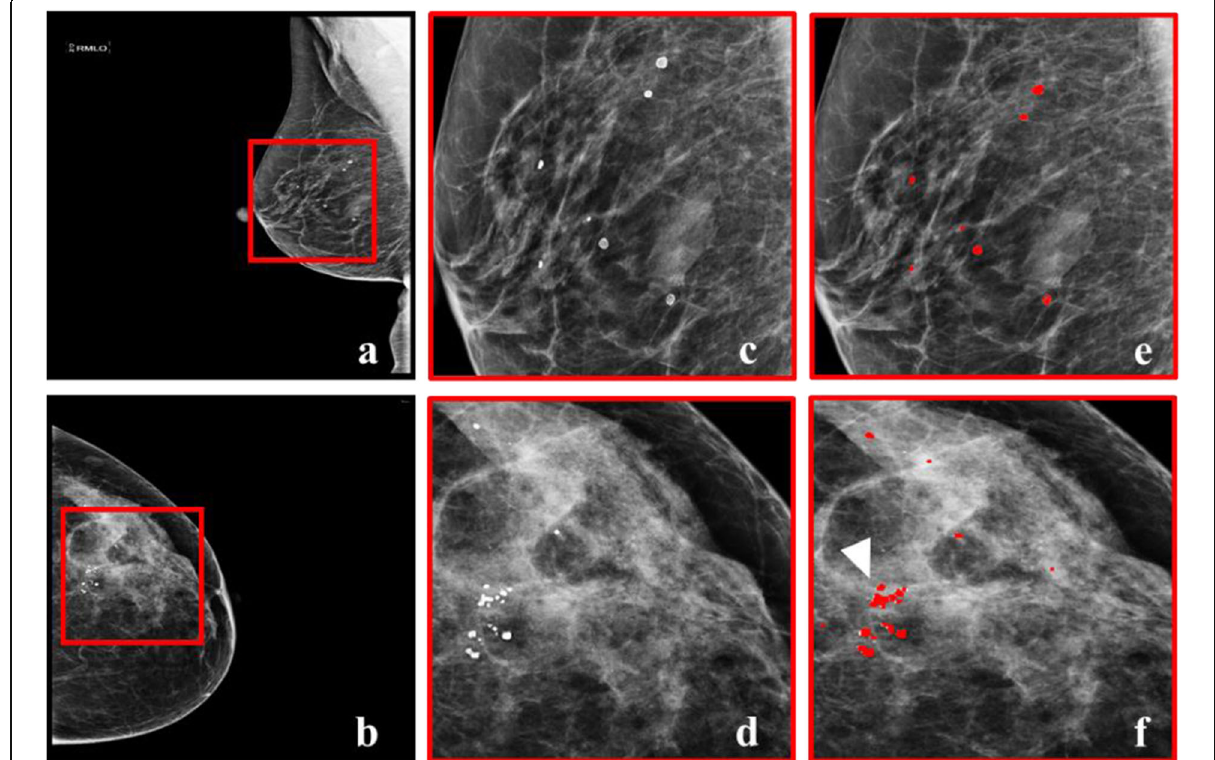
Fig. 2 Dataset examples. a Most recent mammographic view of a woman (BI-RADS breast density class b ) with BI-RADS benign microcalcifications. b Most recent mammographic view of woman (BI-RADS breast density class c ) with BI-RADS benign and suspicious microcalcifications. c , d Zoomed regions from a and b showing microcalcifications. e , f The regions in c and d with precise marking of the location of microcalcifications, as annotated by two expert radiologists. The arrowhead in f points to a BI-RADS suspicious